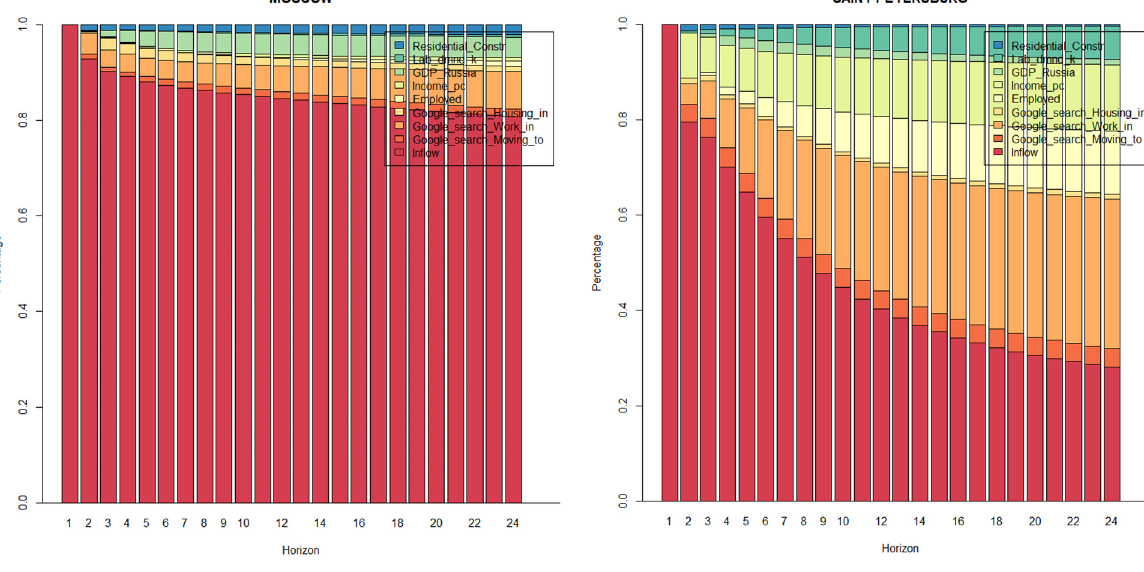
Figure A5. Forecast error variance decomposition of the VECM (1) with centered seasonal dummies: Moscow ( left panel ); Saint Petersburg ( right panel ).